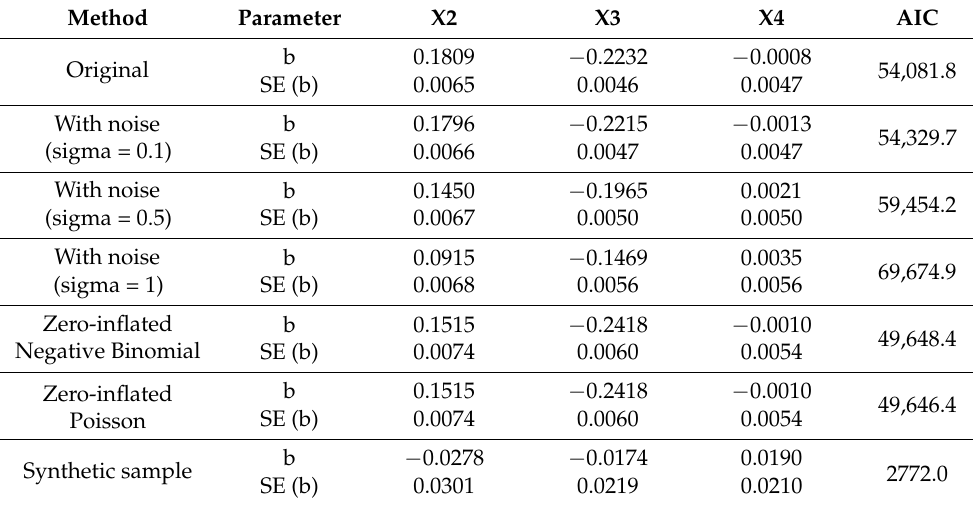
Table 6. Performance evaluation between comparative methods (simulation data 2 with low